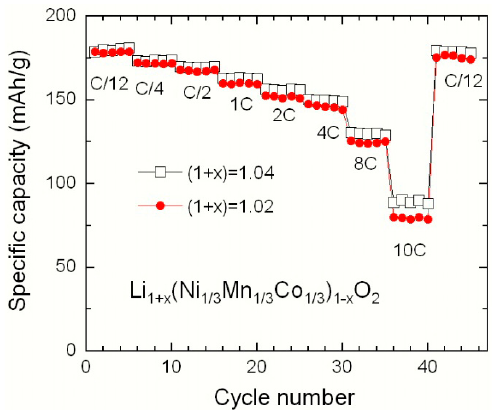
Figure 10. Electrochemical performance of Li 1+x (NMC) 1-x O 2 electrode materials as a function of synthetic parameters. The specific capacity of the Li cells is plotted for different C-rates.